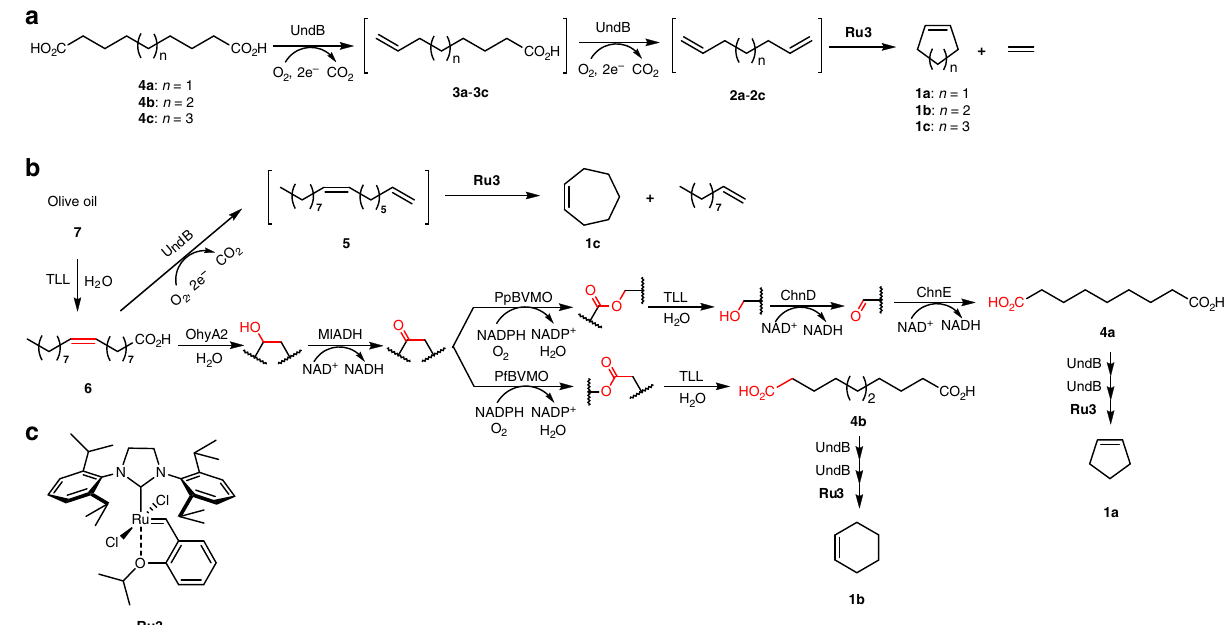
Fig. 2 Chemo-enzymatic cascades to produce cycloalkenes from dicarboxylic acids, oleic acid, and olive oil. a Conversion of diacids ( 4a - 4c ) to cycloalkenes ( 1a - 1c ) via a concurrent bis-decarboxylation and metathesis. b Chemo-enzymatic cascades for the conversion of olive oil ( 7 ) or oleic acid ( 6 ) to cycloheptene ( 1c ), cyclopentene ( 1a , via azelaic acid, 4a ) and cyclohexene ( 1b , via sebacic acid, 4b ). c Structure of the selected RCM catalyst